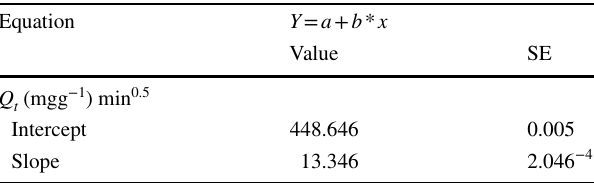
Table 3 Statistical presentation of intraparticle diffusion data for CuO–kaolinite composite derived from linear fit of Fig. 6